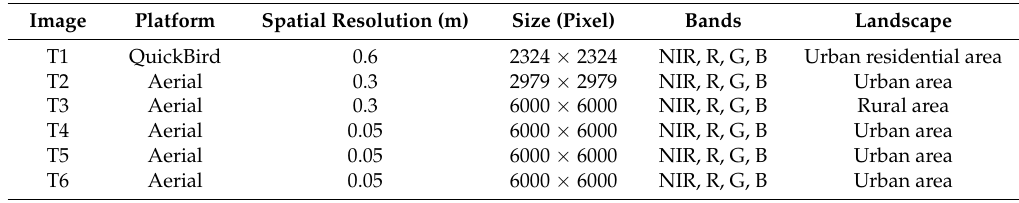
Table 2. The list of test